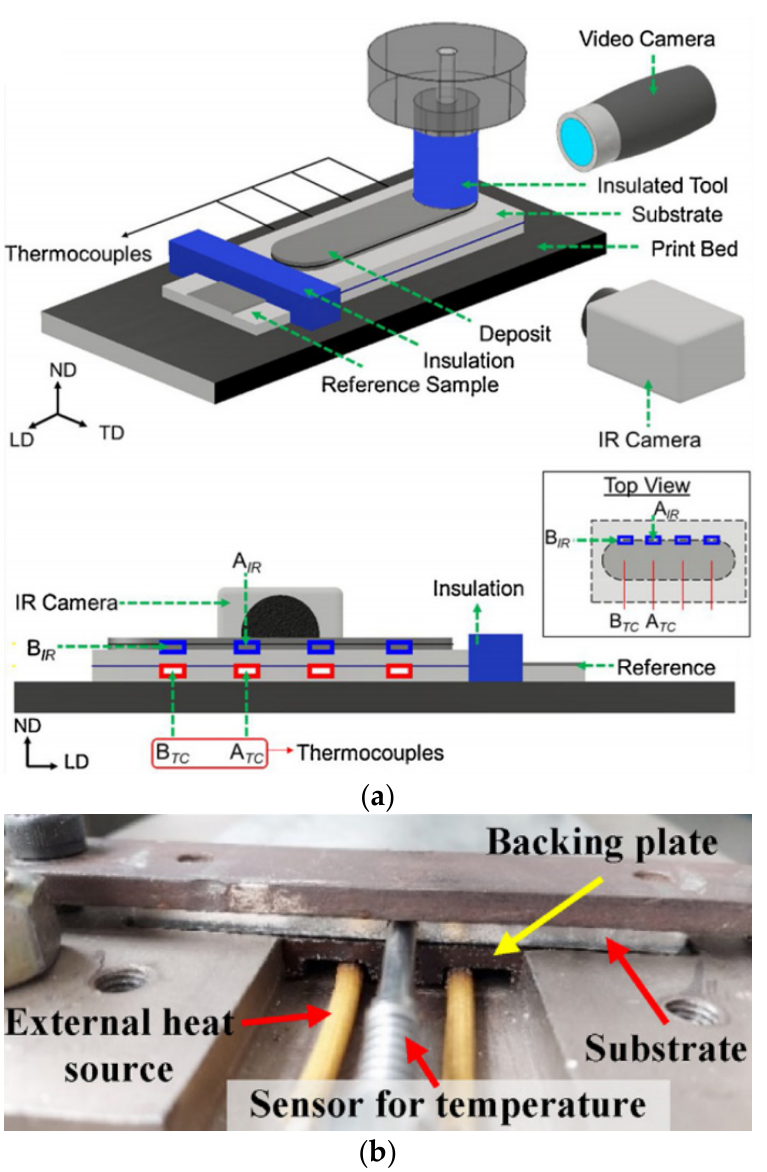
Figure 5. The device for temperature monitoring and extra heating. ( a ) The designed temperature monitoring device during AFSD. ( b ) The designed apparatus for the extra heating source.